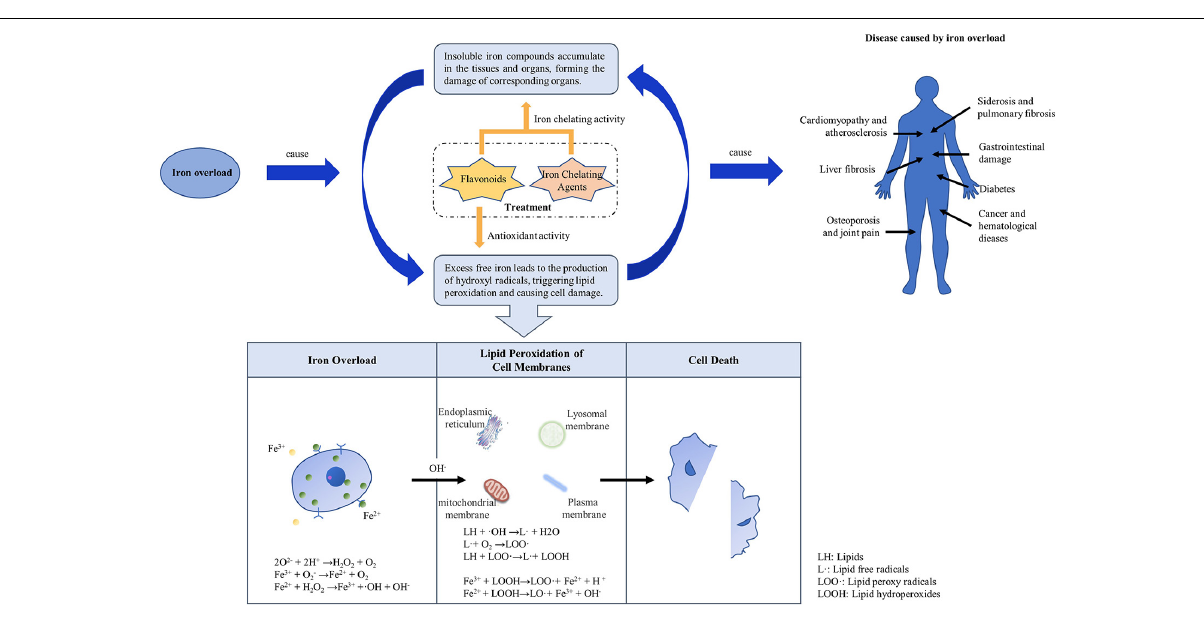
FIGURE 2 | Mechanism of iron overload causing